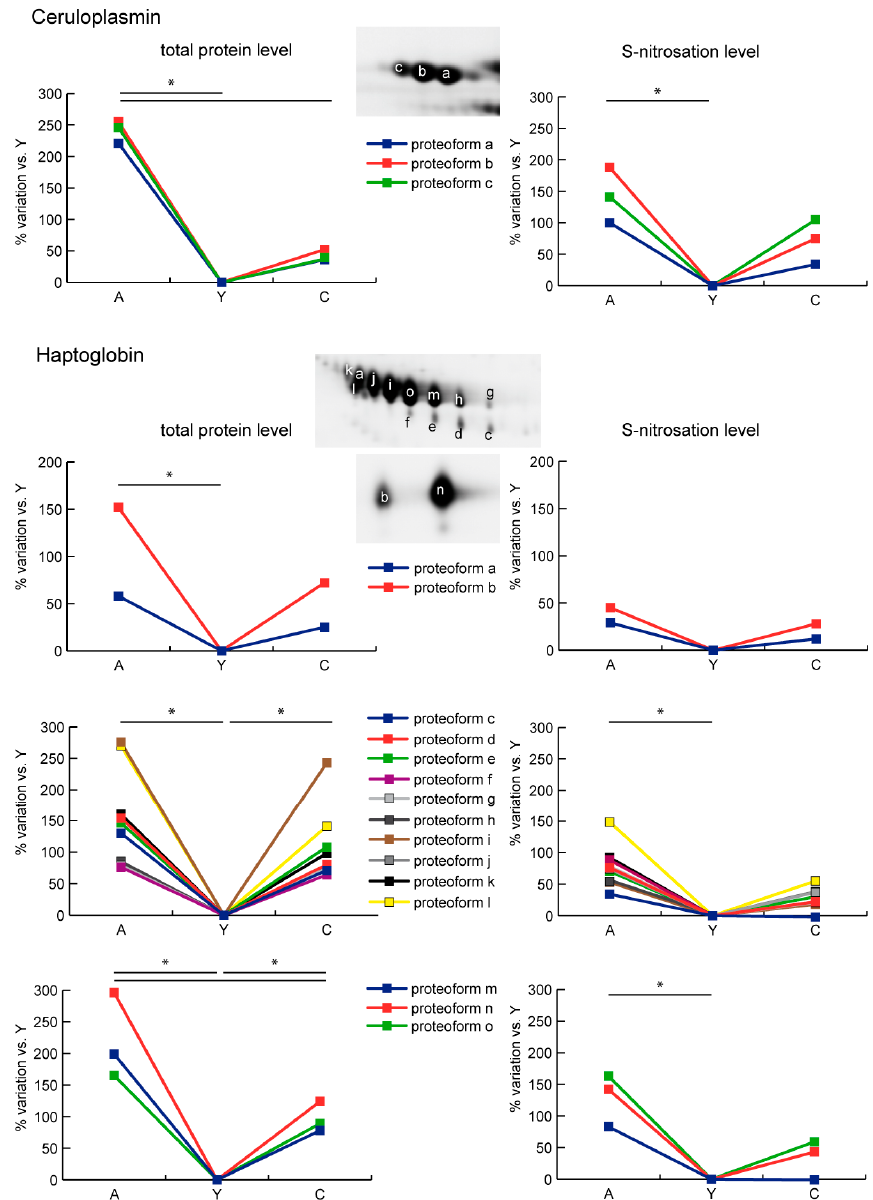
Figure 4. Line charts illustrating ceruloplasmin (CP) and haptoglobin (HP) proteoform abundance and S-nitrosation level variations (%) in sera of aged (A) and centenarian (C) compared to young (Y) women. Proteins were divided according to the statistical significance of the test (* = significant difference, ANOVA and Tukey, n = 6 (2-D DIGE) or n = 9 (Nitro-DIGE), p -value < 0.01). Clusterin (CLU) and immunoglobulin heavy chain gamma (IGHG3) decreased in A vs. Y and C, and were not differentially S-nitrosated. Likewise, low molecular weight proteoforms (LMW) of immunoglobulin light chain 1 (IGLC1) decreased in A compared to Y and C. Nitrosation levels did not change significantly with age. Conversely, upper proteoforms (HMW), despite unchanged levels of total protein, showed decreased levels of S-nitrosation in C (Figure 5).